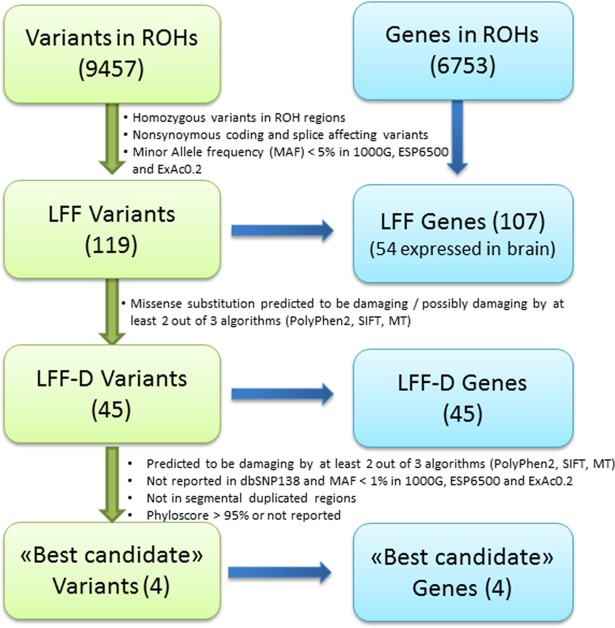
Pipeline for filtration of low frequency functional variants.